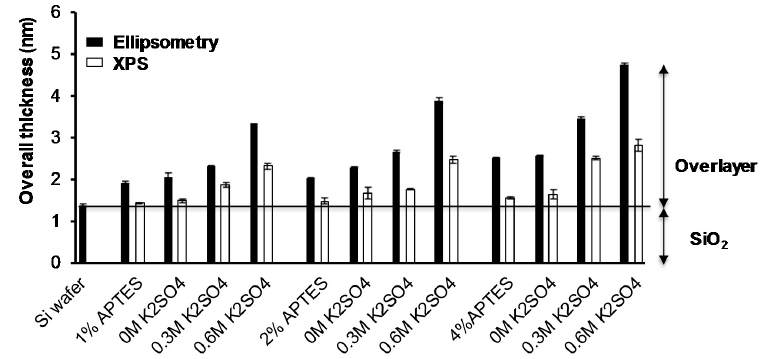
Figure 3. Overlayer thickness of Si wafer, APTES and PEG grafted surfaces measured using ellipsometry and XPS. Data shown: mean ± STD of the mean ( n = 3).